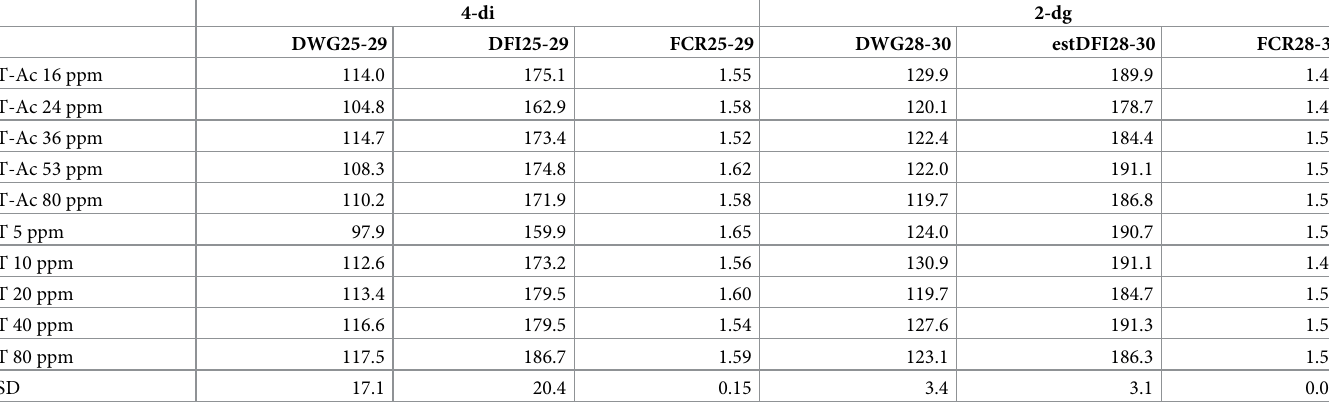
Table 3. Performance data during the test period (DWG = daily weight gain, g/d; DFI = daily feed intake, g/d; FCR = food conversion ratio).